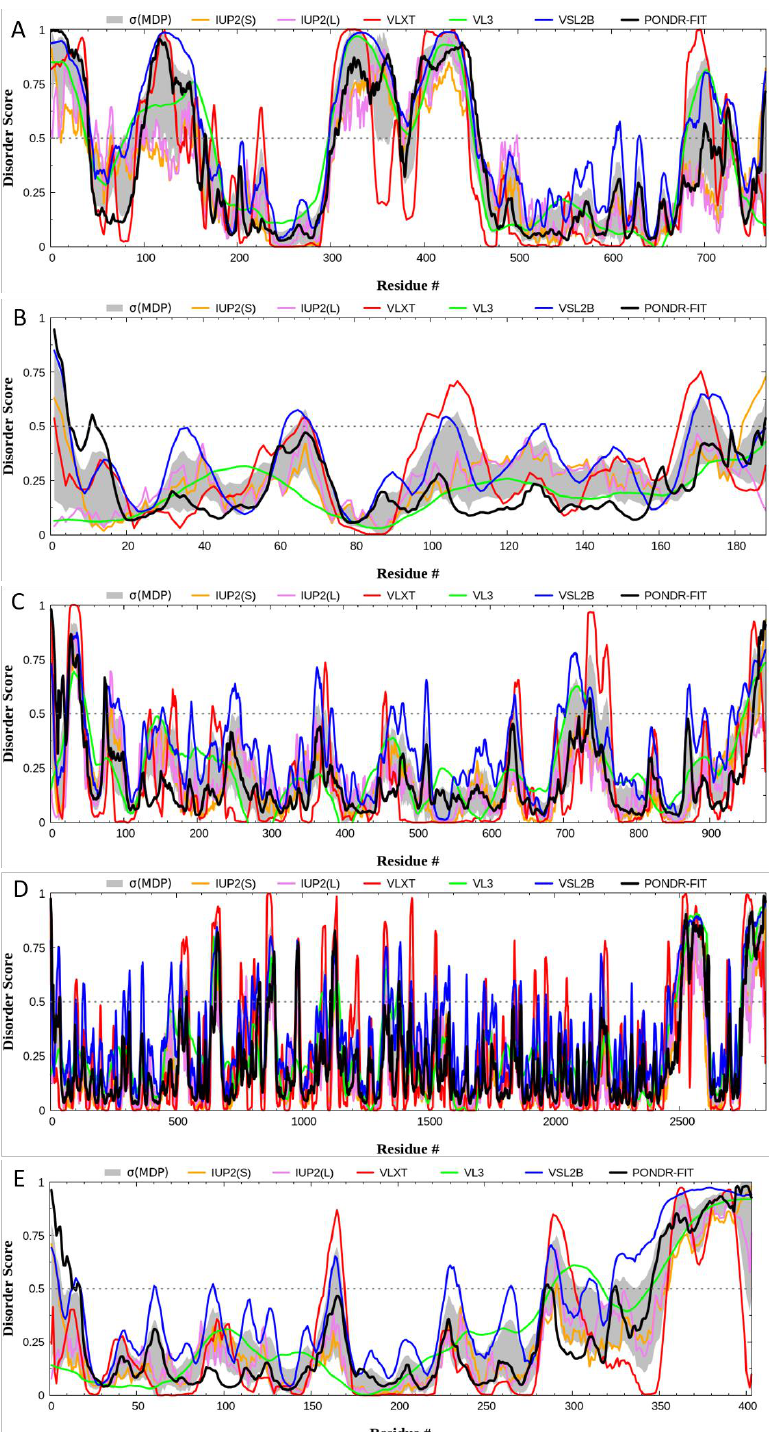
Figure 5. Per-residue intrinsic disorder profiles generated for human BRAF ( A ), NRAS ( B ), c-KIT ( C ), NF1 ( D ), and PTEN ( E ) by mean disorder profile (MDP) and by well-known disorder predictors, including IUPred2 (Short (S)) and IUPred2 (Long (L)), PONDR ® VLXT, PONDR ® VL3, PONDR ® VLS2, and PONDR ® FIT. The outputs of the evaluation of the per-residue disorder propensity by these tools are represented as real numbers between one (ideal prediction of disorder) and zero (ideal prediction of order). A threshold of 0.5 was used to identify disordered residues and regions in query proteins. All five proteins show extensive intrinsic disorder, and BRAF’s quantity of intrinsic disorder was the highest at 36.73% by average disorder